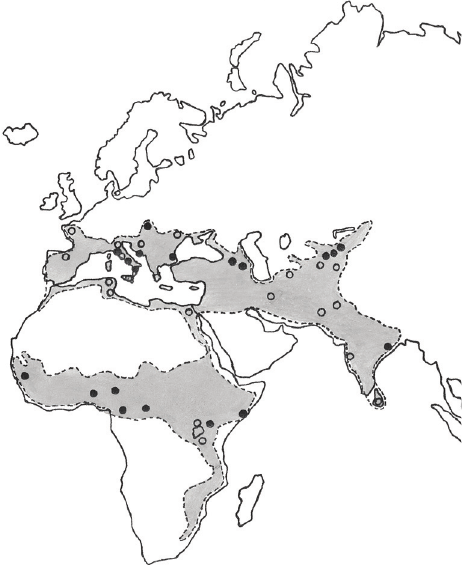
Figure 1: Bhanja virus distribution. Black points: virus isolation; circles: antibodies to BHAV present in vertebrates.